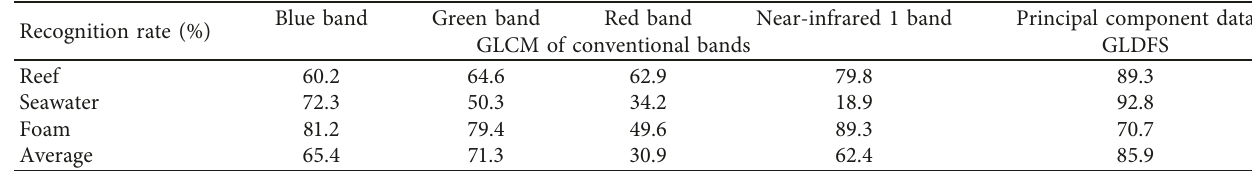
Table 1: The recognition rate of GLDFS and GLCM of conventional bands.